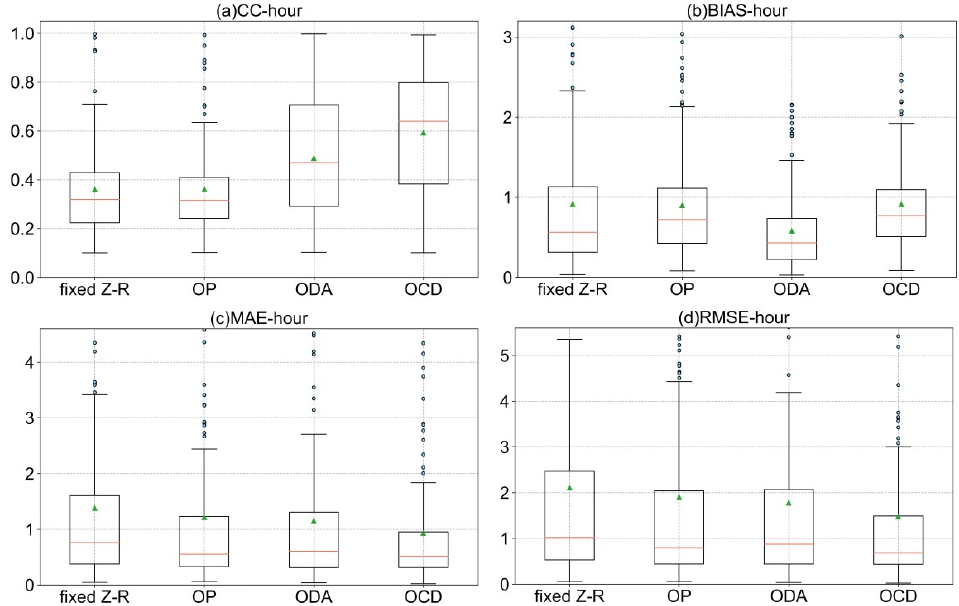
Figure 4. The distribution of the evaluation indicators for fixed Z-R, OP, ODA, and OCD at hourly scales, ( a ) CC, ( b ) BIAS, ( c ) MAE, ( d ) RMSE.